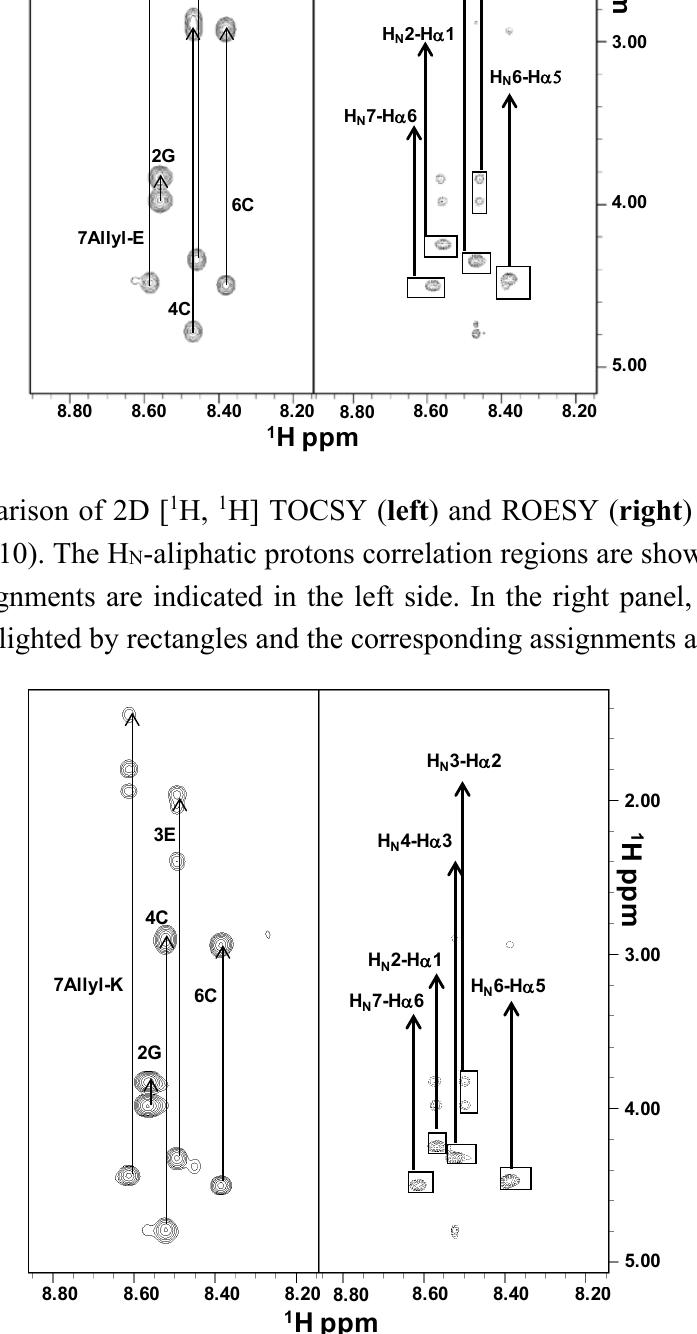
Figure 3. Comparison of 2D [ 1 H, 1 H] TOCSY ( left ) and ROESY 200 ( right ) spectra of PepK in H 2 O/D 2 O (90/10). The two sides of the figure show spectral regions containing H N /aliphatic protons correlations; spin system assignments are indicated in the TOCSY left panel. In the right panel, sequential ROE contacts are